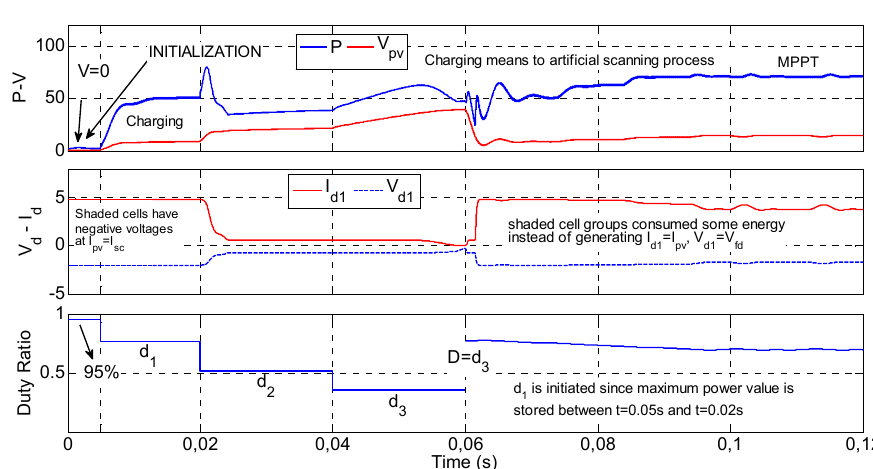
Shaded cells have negative voltages at I pv =I sc